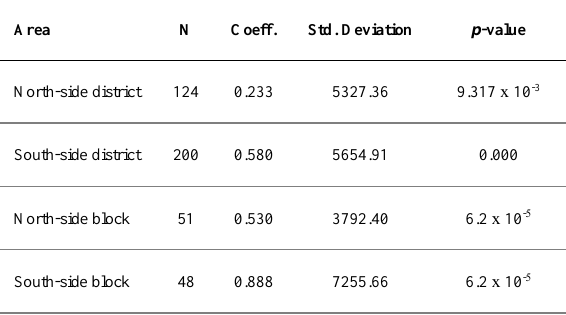
Table 10. Estimated coefficients for the total floor area (m 2